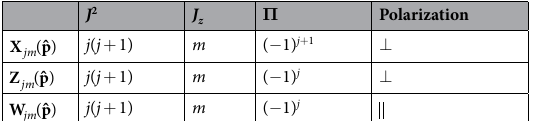
Table 1. Vector multipolar functions: Polarization character and eigenvalues of J 2 , J z and parity Π . The symbol ⊥ means transverse polarization. The symbol means longitudinal polarization. Both j and m are integers, and = − … m j j . For ˆ X p ( ) and ˆ Z p ( ) , j > 0. For ˆ W p ( ) , j ≥ jm jm jm